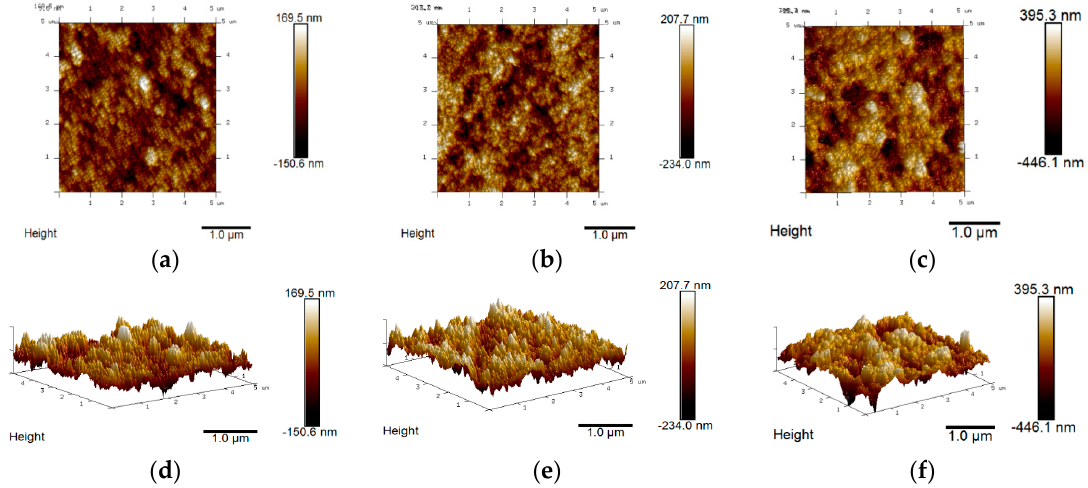
Figure 1. AFM top view images and 3D maps of ( a , d ) unmodified, ( b , e ) 5% and ( c , f ) 10%-Ti modified hematite electrodes.